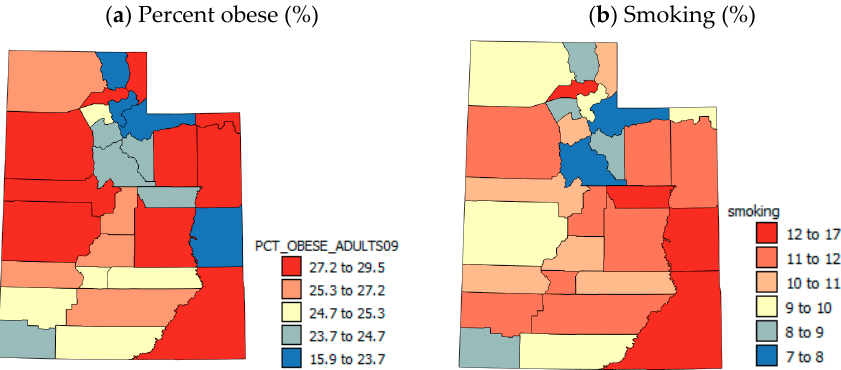
Figure 4. Maps of health behavior variables.